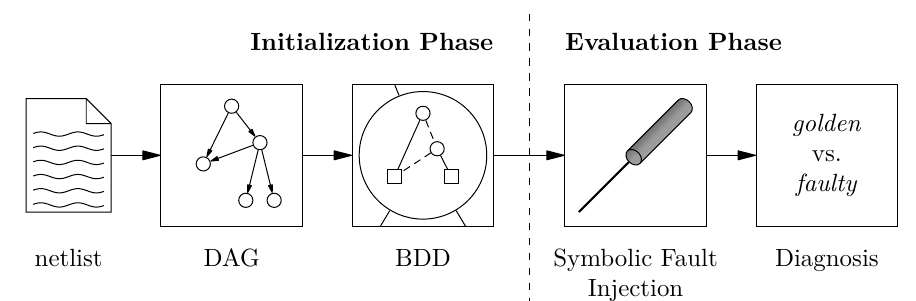
Figure 2: Flow of the proposed verification